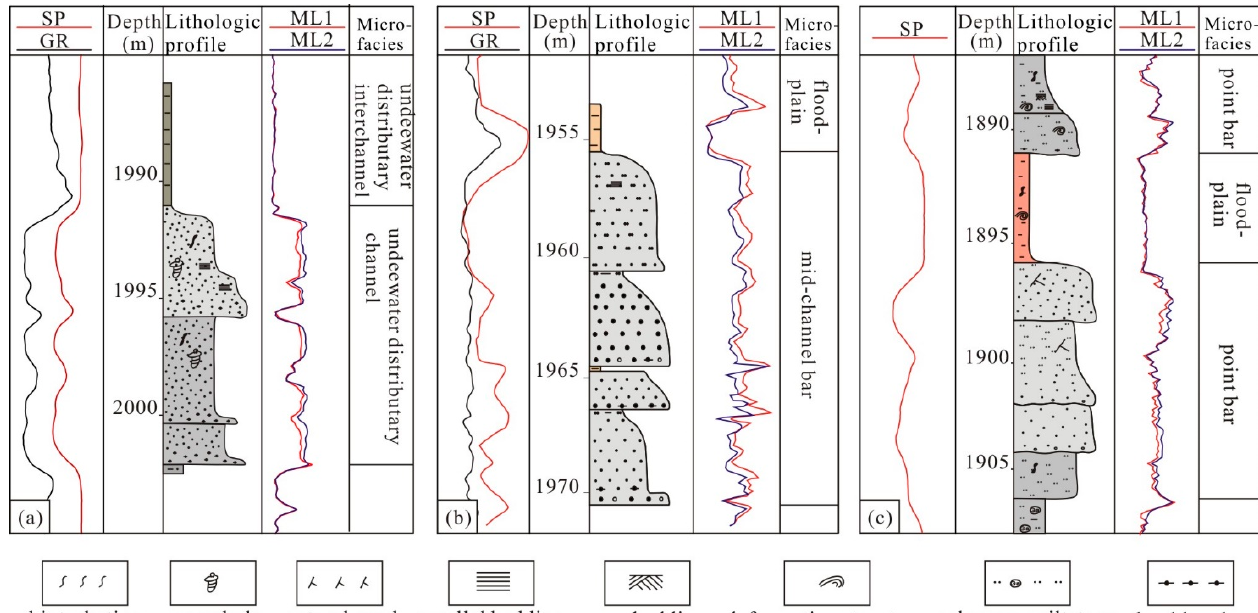
Figure 3. The main sedimentary microfacies characteristics of E 2 s 14–7 in the Zhenwu area, Gaoyou Sag. ( a ) Zhenjian 4, delta facies; ( b ) Zhen 140, braided fluvial facies; ( c ) Zhenjian 1, meandering fluvial facies.